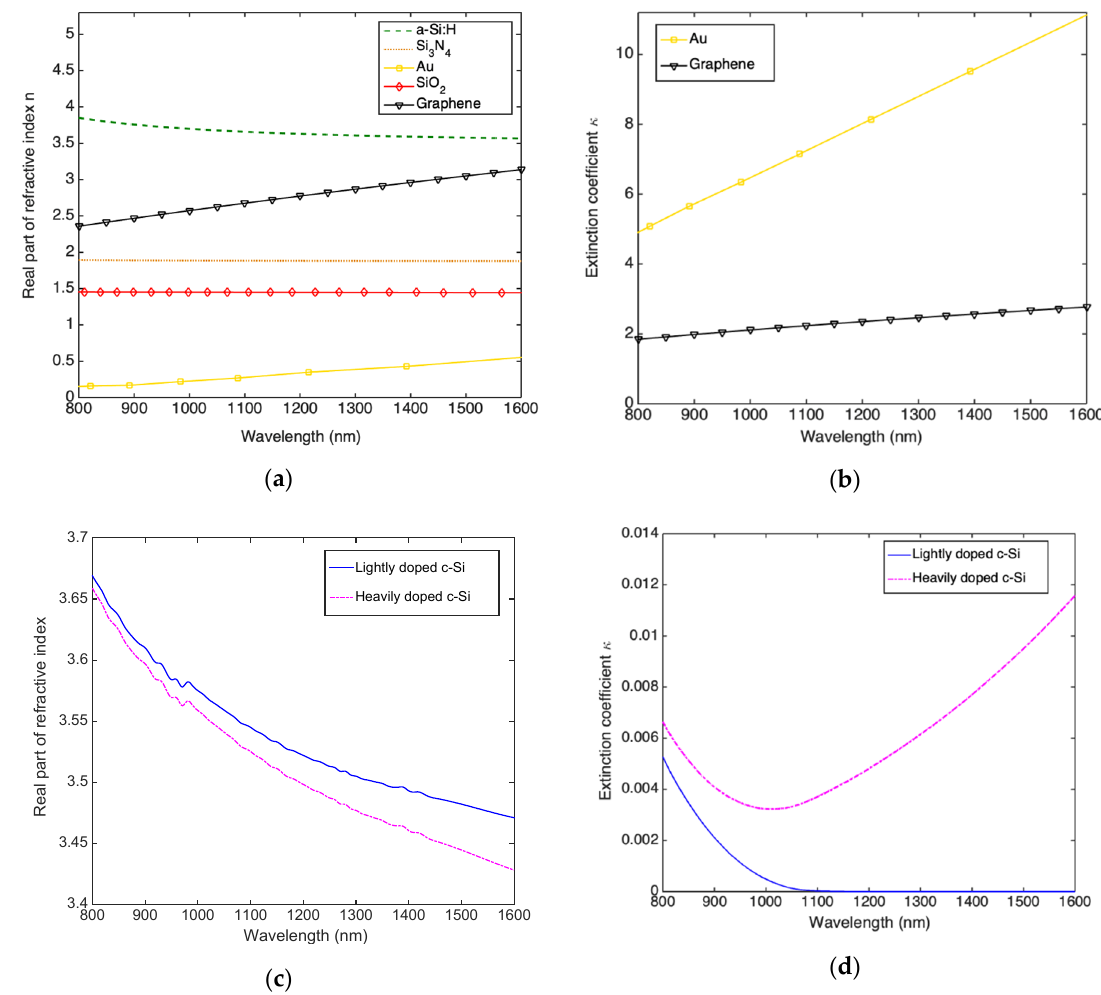
Figure 3. Dispersion curves of all materials used in our numerical simulation: ( a ) real part of refractive index and ( b ) extinction coefficient of a-Si:H, Si 3 N 4 , Au, SiO 2 and graphene. ( c ) real part of refractive index and ( d ) extinction coefficient of lightly (1 × 10 15 cm − 3 ) and heavily doped (5 × 10 19 cm − 3 ) c-Si.